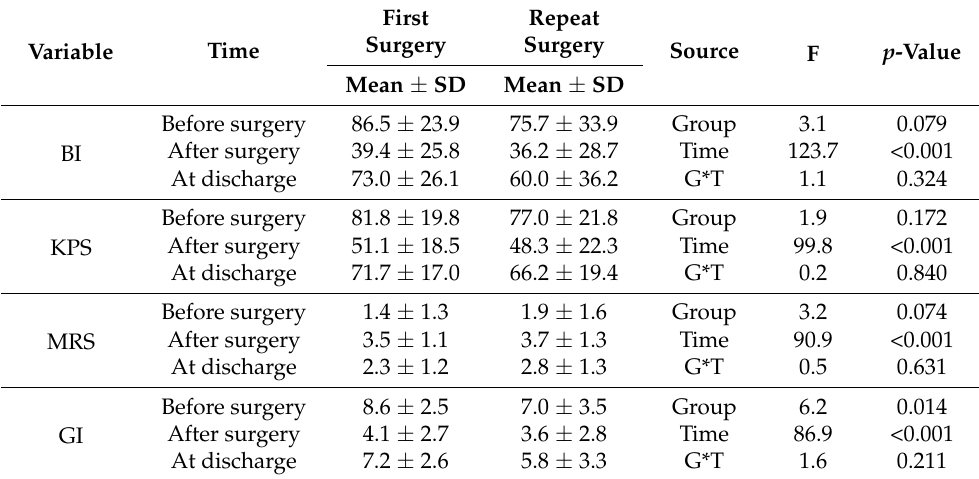
Table 4. Activities of daily living, performance, self-reliance, and gait efficiency before surgery, after surgery, and at discharge.